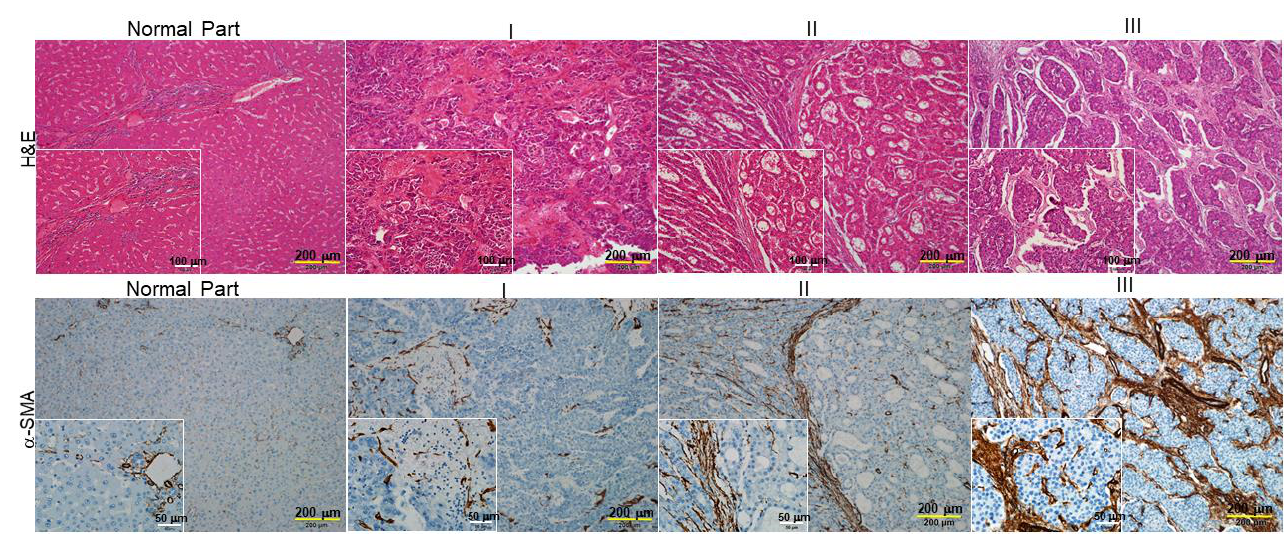
Figure 1. Histological analysis of the association between hepatic fibrosis and HCC stages (I, II, III). Upper panels: Liver fibrosis was determined by hematoxylin and eosin (H&E) staining (bar scale 200 µ m and 100 µ m). Lower panels: IHC analysis of α -smooth muscle actin ( α -SMA) expression in normal and different stages of hepatocellular carcinoma tissues (bar scale 200 µ m and 50 µ m). The positive signal is indicated in brown and their magnified images are shown in lower right squares. I, II and III indicated stages of HCC.